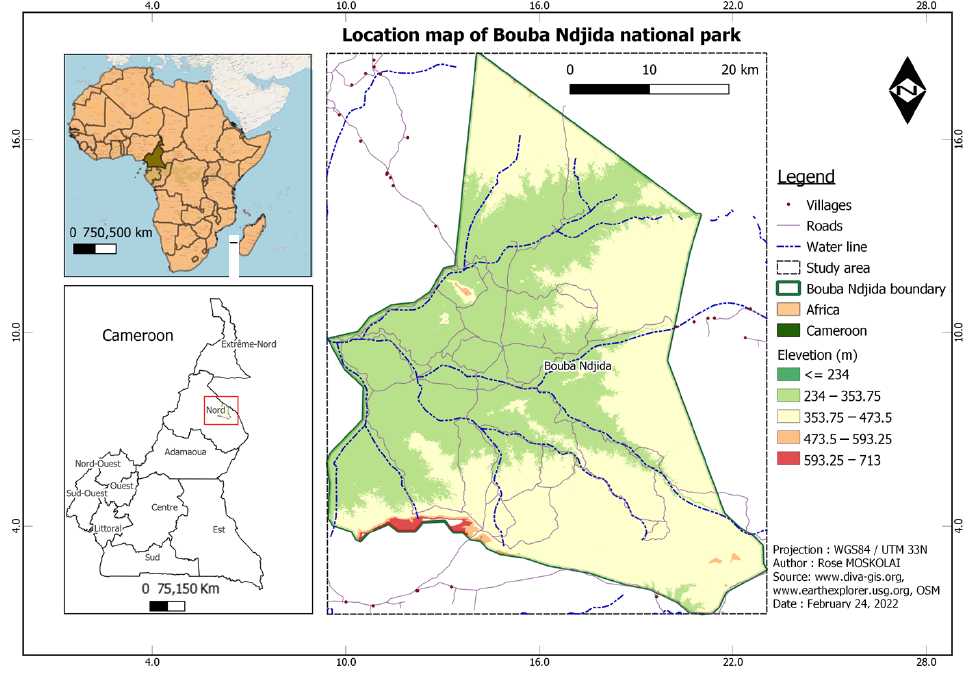
Figure 1. Location map of the Bouba Ndjida National